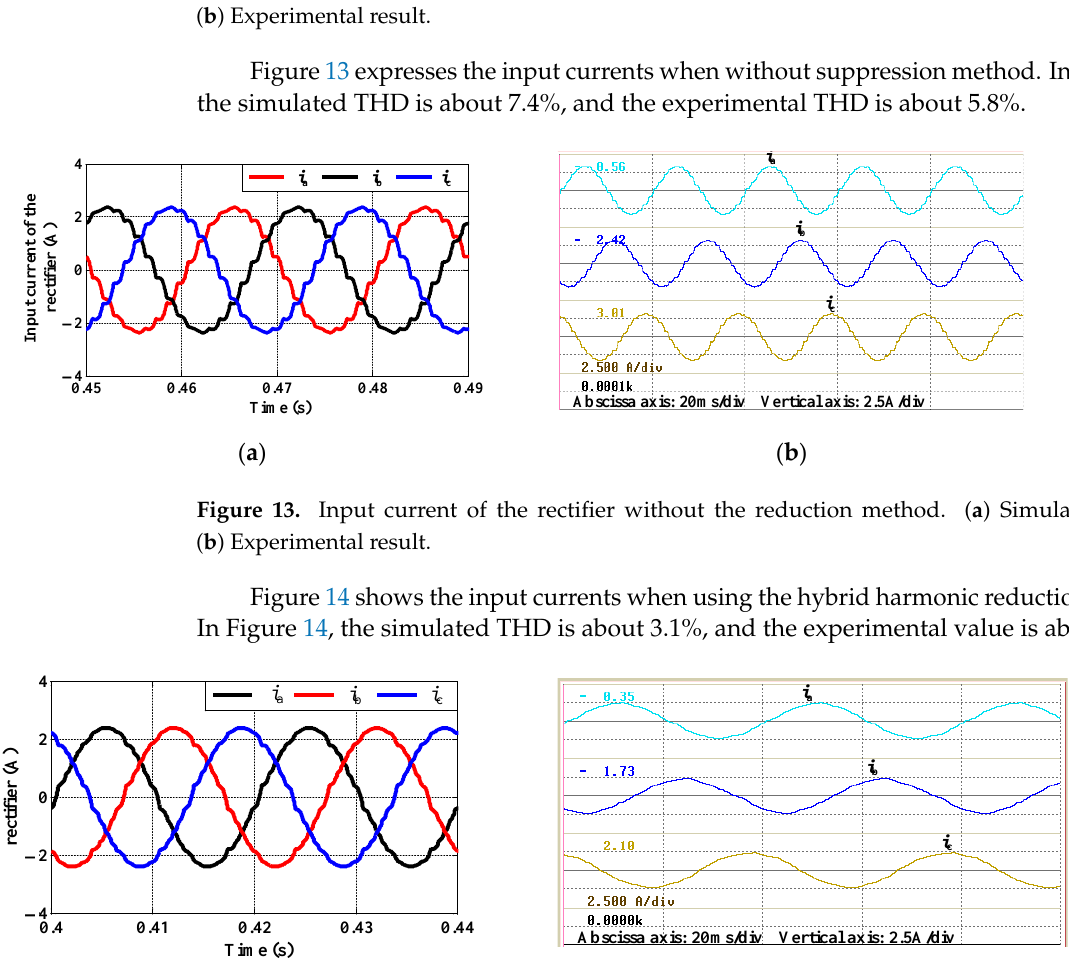
Figure 14. Input current of the converter with the reduction method. ( a ) Simulation result. ( b ) Experimental result.